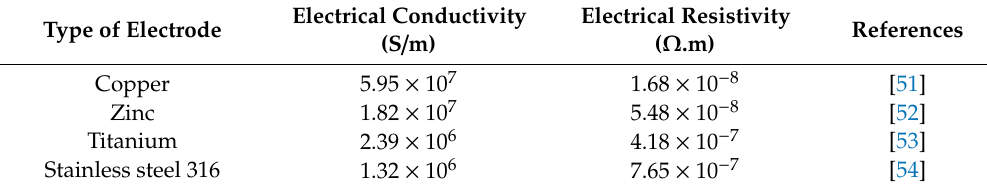
Table 4. Electrical conductivity and electrical resistivity of di ff erent types of electrodes.